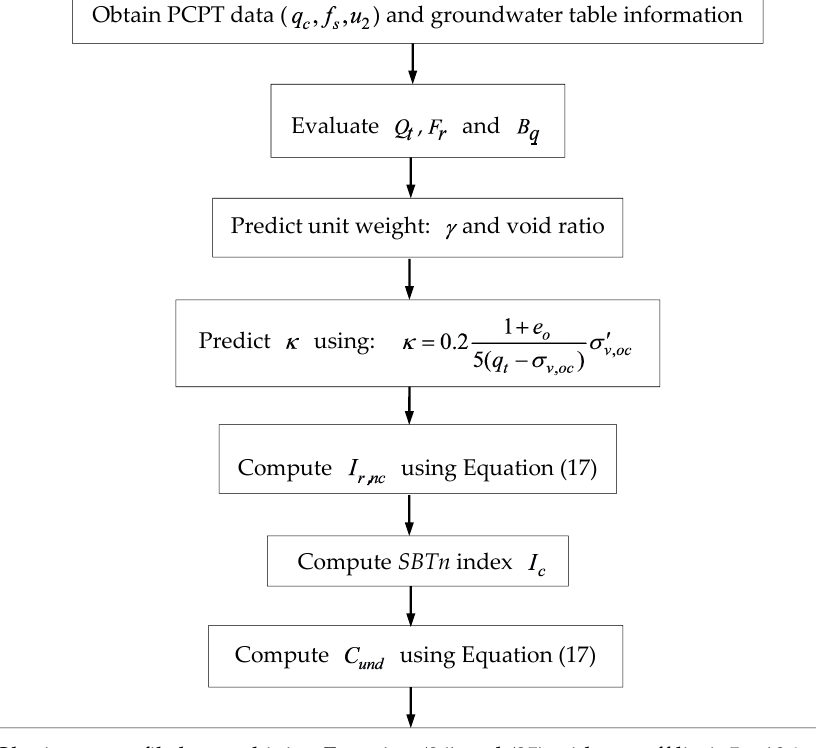
Figure 6. Steps used to compute hydraulic conductivity of OC soils from PCPT (predictions for unit weight and κ are obtained from Robertson and Cabal [29] and Song and Pulijala